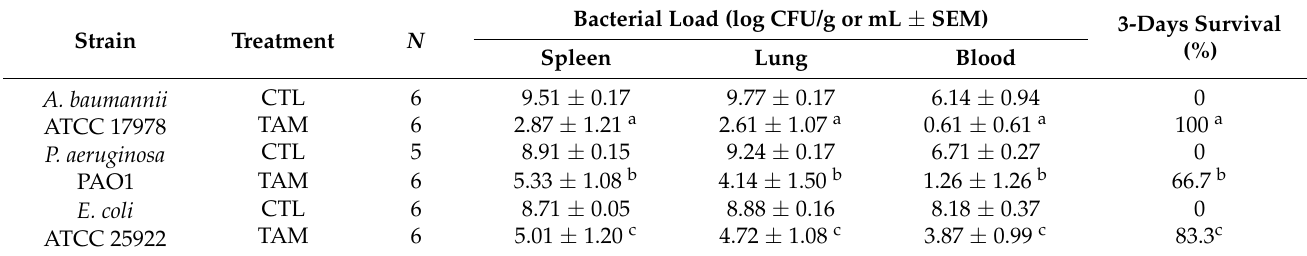
Table 1. Tamoxifen shows therapeutic efficacy in murine sepsis models by Gram-negative bacilli (GNB). Bacterial Load (log CFU/g or mL ± SEM) 3-Days Survival Strain Treatment N (%)Spleen Lung Blood